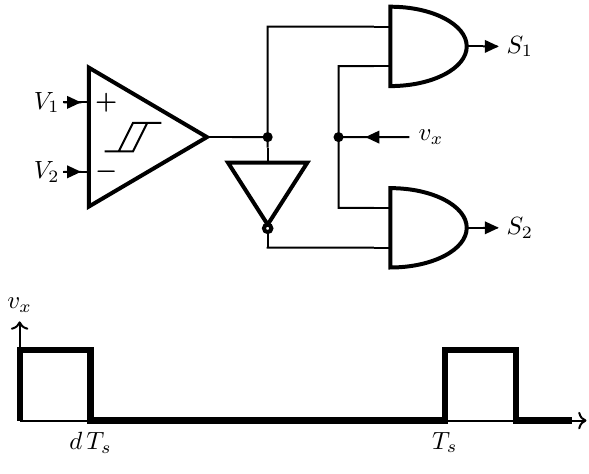
Figure 12. Control scheme of the equalizer circuit.